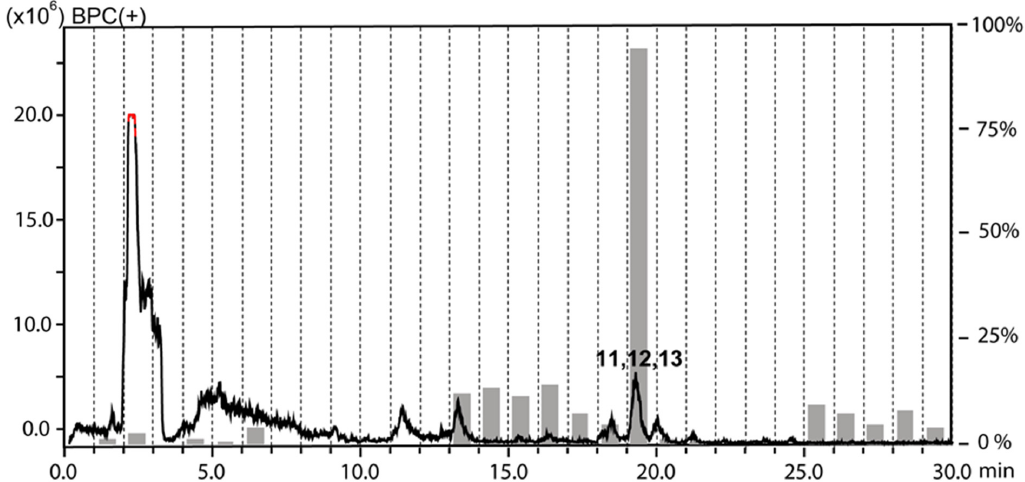
Figure 2. HPLC-based activity profiling of the water fraction against axenic amastigotes of L. donovani . The ESIMS (base peak chromatogram in positive ion mode) from a separation of 300 µg of fraction is shown. For each microfraction the activity is expressed as percent growth inhibition in comparison to untreated cultures (grey bars). Bold numbers in the chromatogram refer to compounds 11 – 13 .